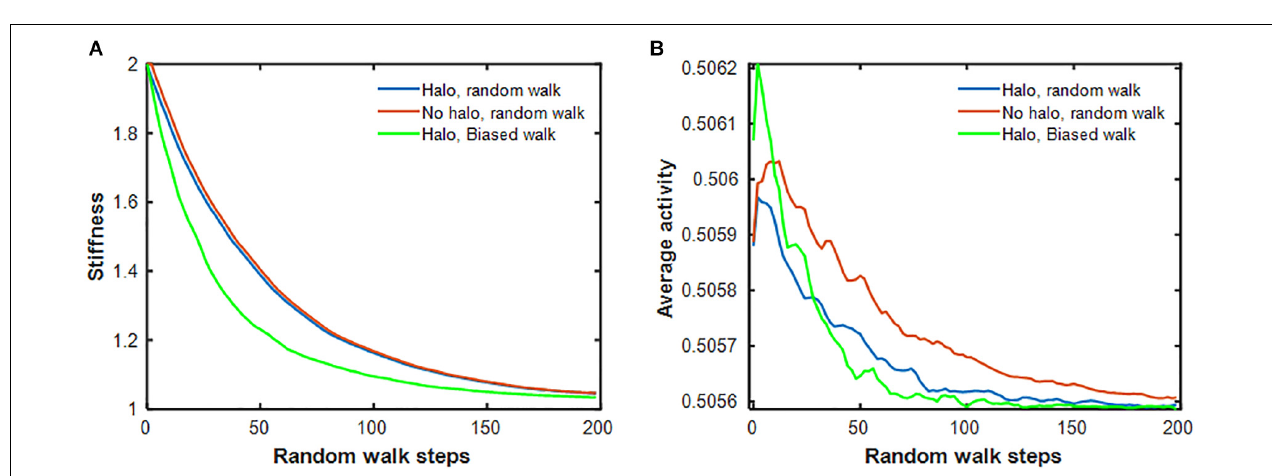
FIGURE 4 | (A) Time course of stiffness decay of the central spring for several values of the number of agents in the network. (B) Comparison of the time course of the activity and stiffness of the network with 250 agents to that of the differential equation. For the network, the average agent activity is plotted. The inset shows a magnified region of the activity of the network.